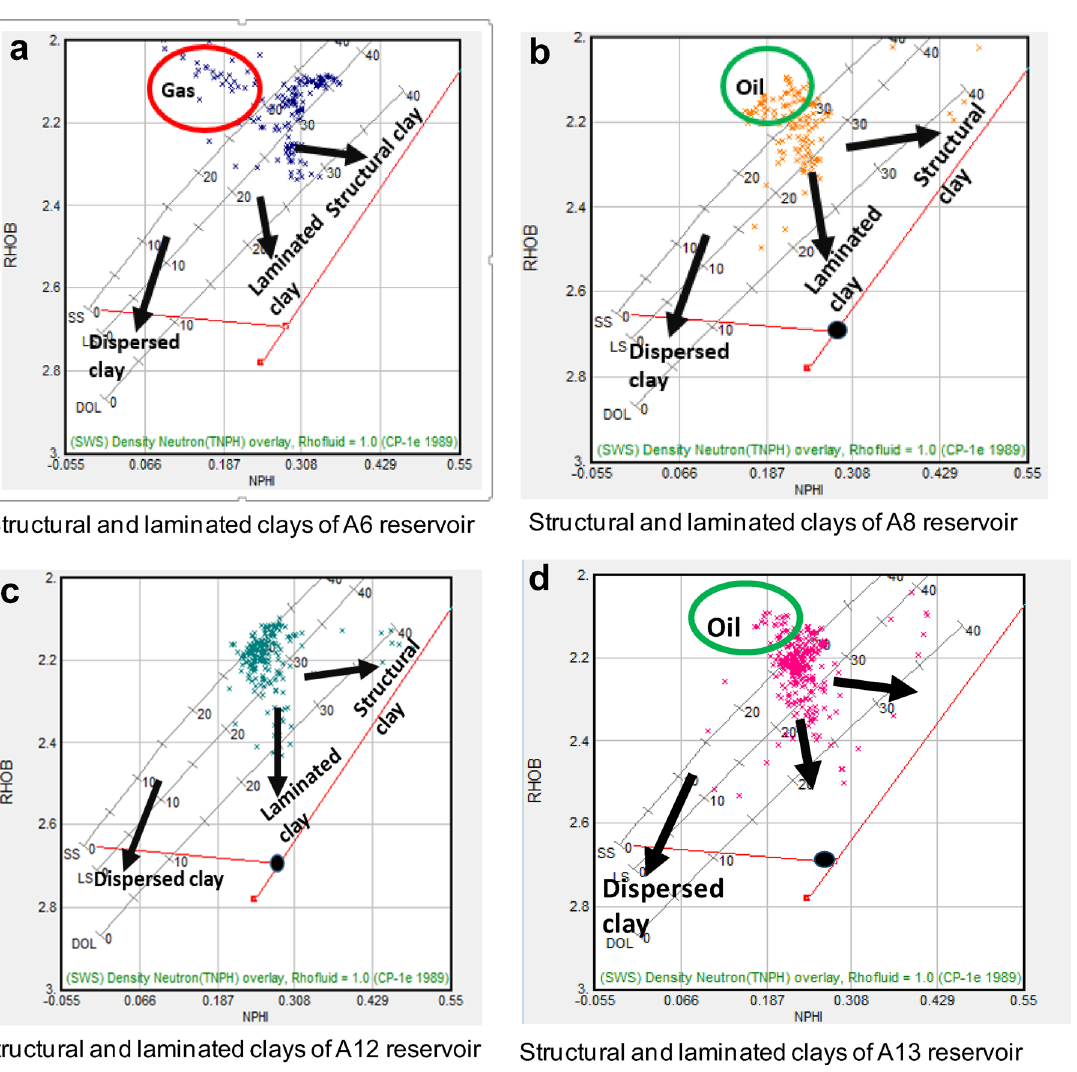
Fig. 11 Neutron–density crossplot model showing the clay distributions in the reservoirs a A6, b A8, c A12 and d A13 of JAP-2